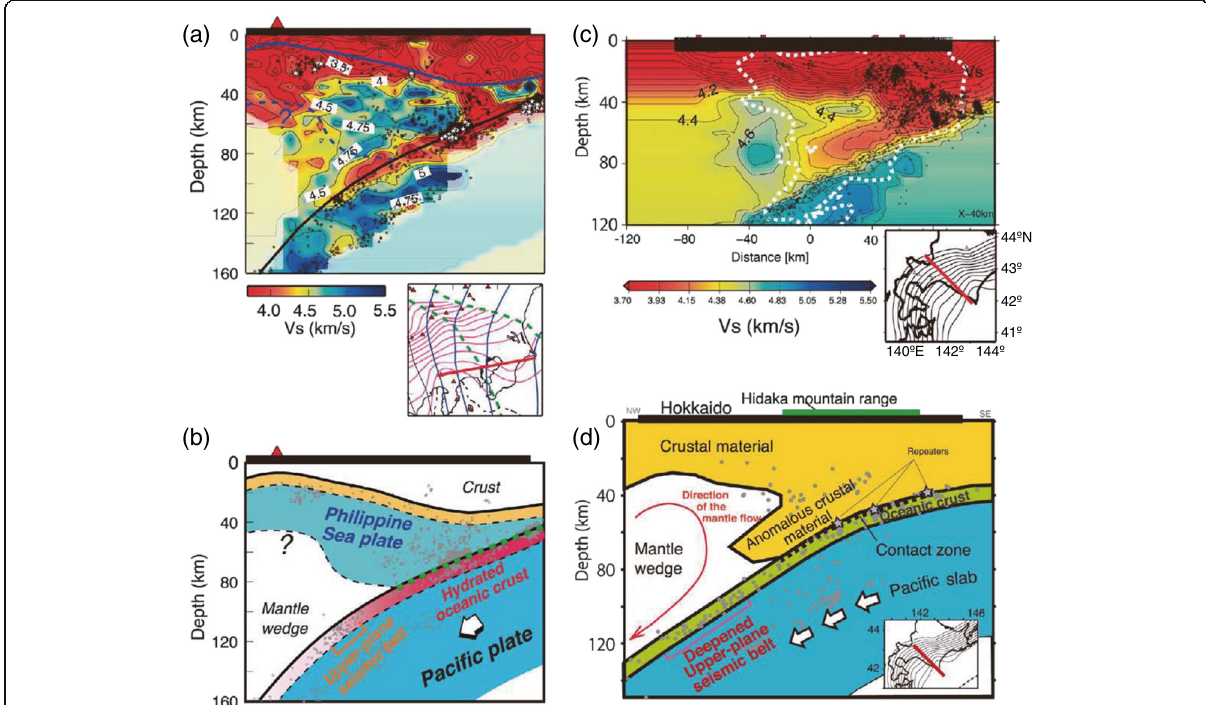
Fig. 9 The contact of the Pacific slab with the overlying Philippine Sea slab or forearc crust. a Vertical cross-section of S-wave velocity along a line under Kanto in the inset map and b schematic figure showing the contact between the Philippine Sea and Pacific slabs (Nakajima et al. 2009b). c Across-arc vertical cross-section of S-wave velocity under western Hokkaido along a line in the inset map and d schematic figure showing the contact between the subducted forearc crust and the Pacific slab (Kita et al. 2010a). S-wave velocity is indicated by the color scale at the